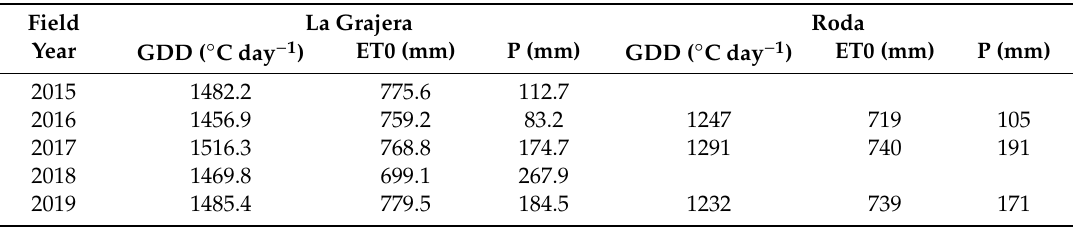
Table 1. Climatic conditions of the two experimental sites. Data are the sum of each year, since 1 May to 1 October [31].